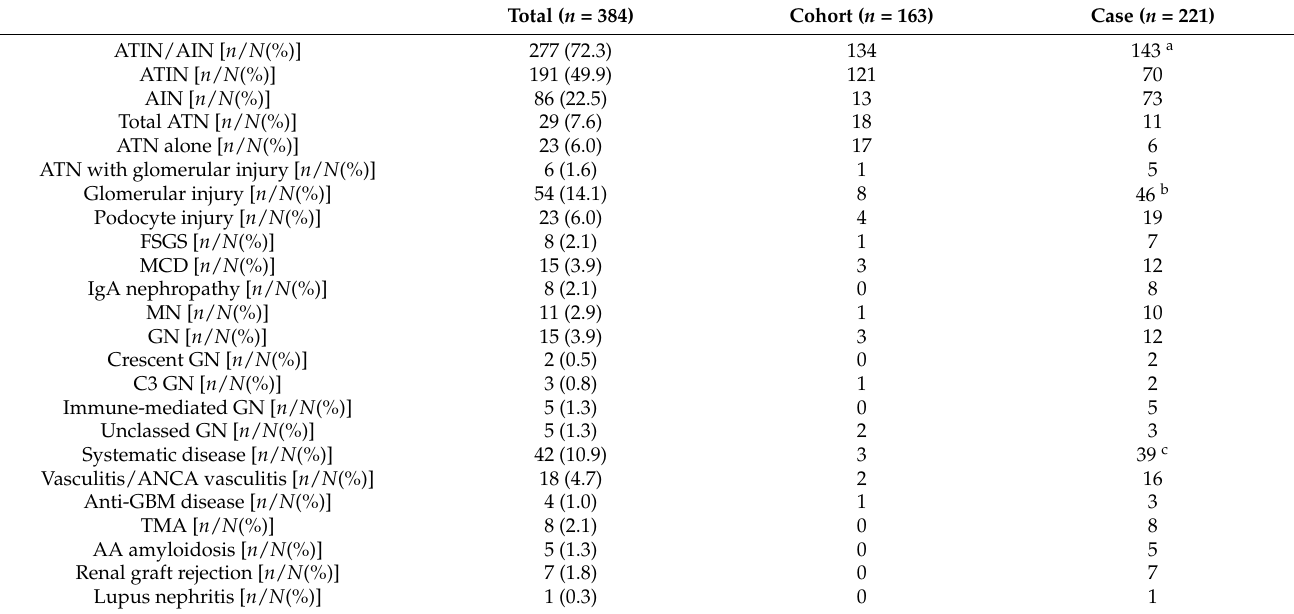
Table 2. Histopathological type of total patients with biopsy-proven kidney IRAEs.